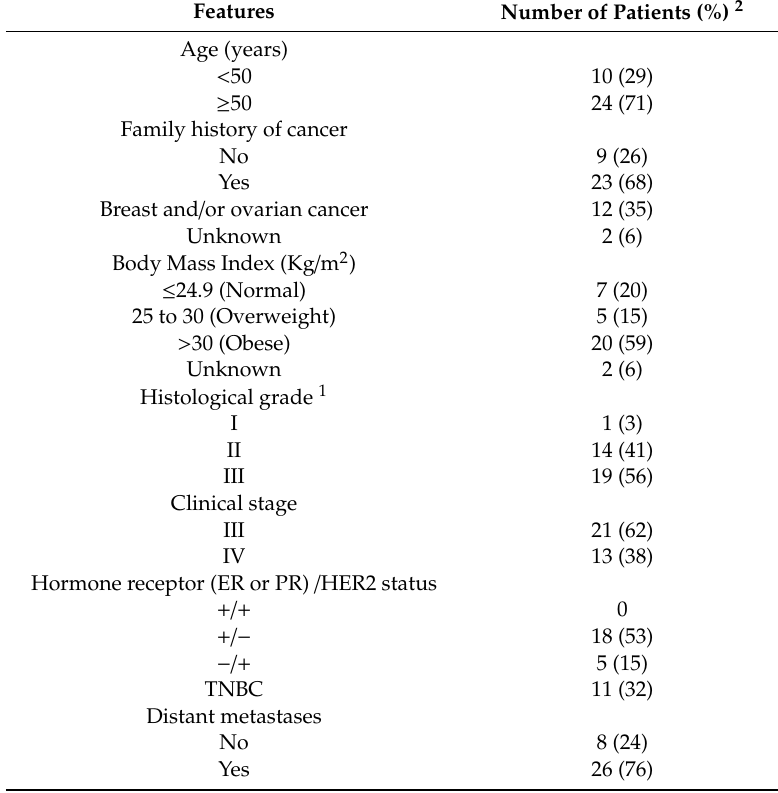
Table 1. Clinical and pathological characteristics of 34 female patients with inflammatory breast carcinomas evaluated in this